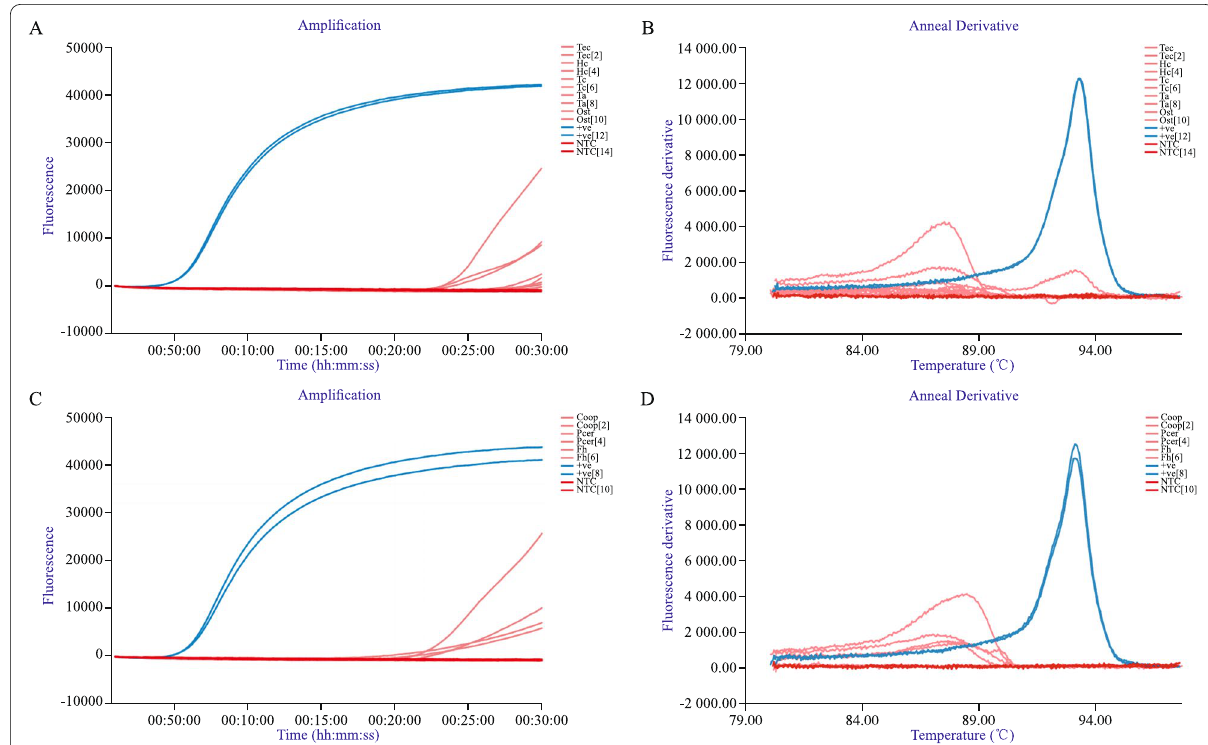
Fig. 1 Specificity panel used to determine AtLAMP specificity using common livestock helminths and F. hepatica. A , C LAMP amplification curves for AtLAMP performed on DNA from common livestock helminths and F. hepatica performed in duplicate (Tec - Teladorsagia circumcincta; Hc - Haemonchus contortus; Tc- Trichostrongylus colubriformis; Ta- T. axei ; Ost- Ostertagia spp.; Coop- Cooperia spp.; Pcer- Paramphistomum cervi ; Fh- F. hepatica; ve-snail DNA; NTC-No template control ). T . axei and Cooperia spp. recorded one of two replicates with T p values exceeding 25 minutes, + with T p values from H. contortus, Ostertagia spp., and F. hepatica exceeding 29 minutes from one of two replicates. B , D The fluorescent derivative annealing curve (T a ) for the corresponding livestock helminths and F. hepatica DNA. No T a values recorded for all helminth species